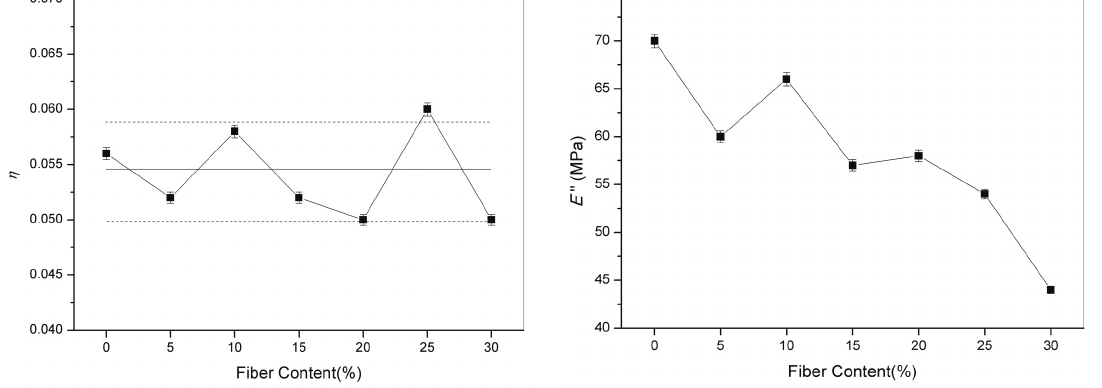
Figure 8. Loss modulus as a function of coconut fiber content.